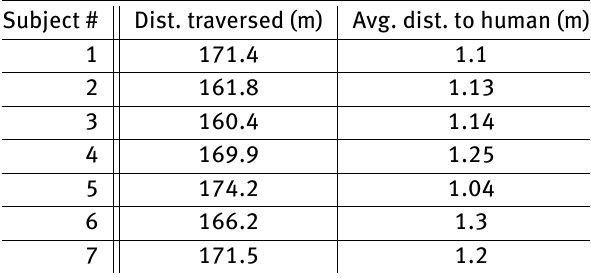
Table 1: Performance of the person follower on seven subjects. Each row shows a run where the robot followed the subject on a course. The distance traversed per run is given in the second column. The average distance between the robot and the human was provided in the third column. The average distance to the person across runs are relatively consistent, and slightly higher than 1 meter because the robot got higher rewards by keeping that much of distance to the human.